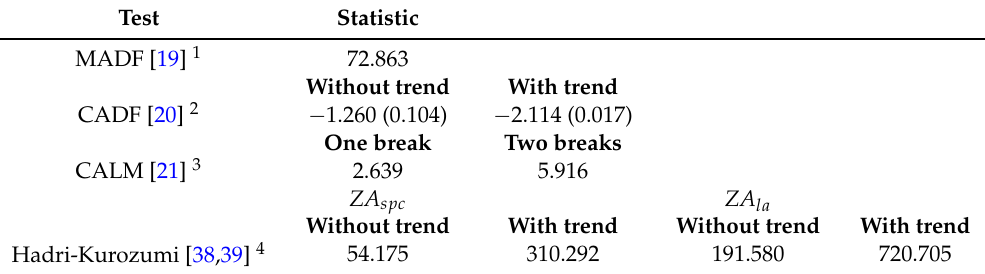
Table 4. 2nd generation panel unit root test result statistics.